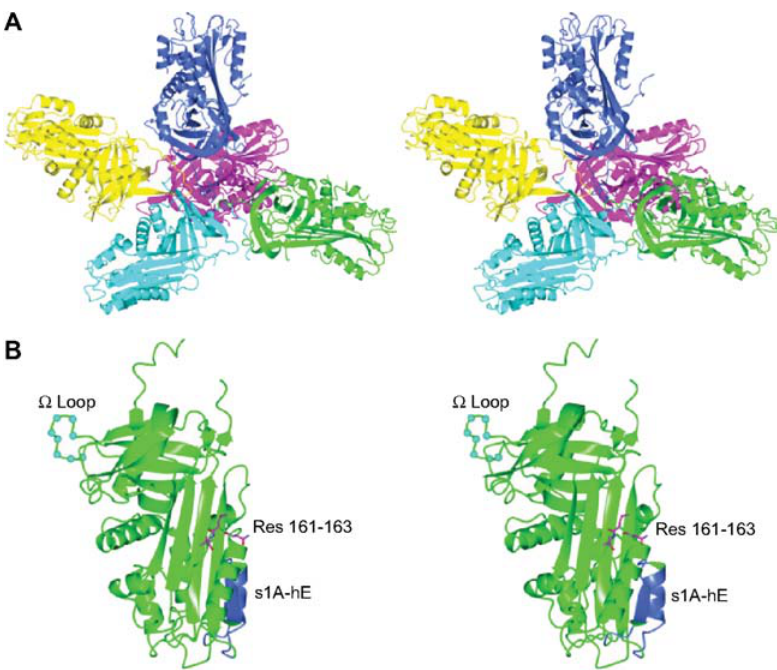
Figure 4 (A) Stereo sketch representation of the crystal packing in the asymmetric unit of full length hNS (pdb code 3F5N). It should be noted that the five RCLs are at the core of the chain-to-chain interaction region. (B) Stereo representation of hNS (pdb code 3FGQ): the omega loop is highlighted as cyan spheres (residues 231–237), residues 161–163 are shown as magenta sticks, and the region s1A-hE is in